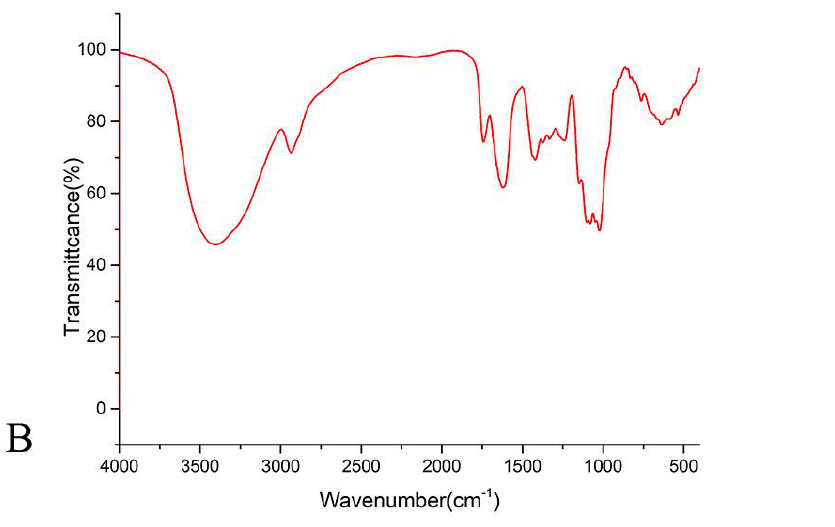
Figure 5. The FT-IR fingerprints. ( A ) the FT-IR fingerprints of different SPs ( B ) the FT-IR standard referential fingerprint of SPs.